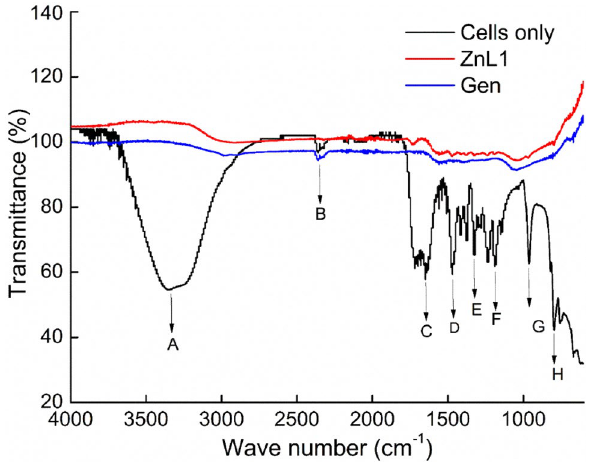
Figure 3. Representative FTIR spectra of cell pellets from A. baumannii treated with MIC of ZnL1 compared with MIC of Gen and untreated control.